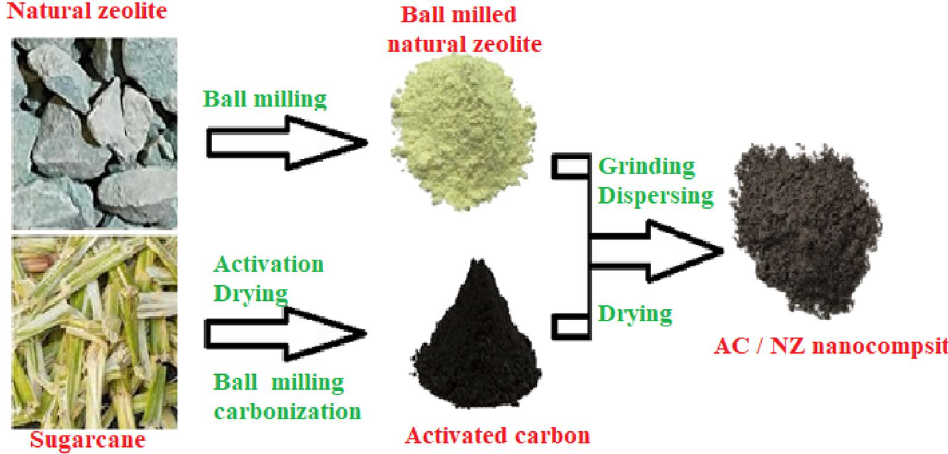
Figure 1. Schematic of the synthesis steps of